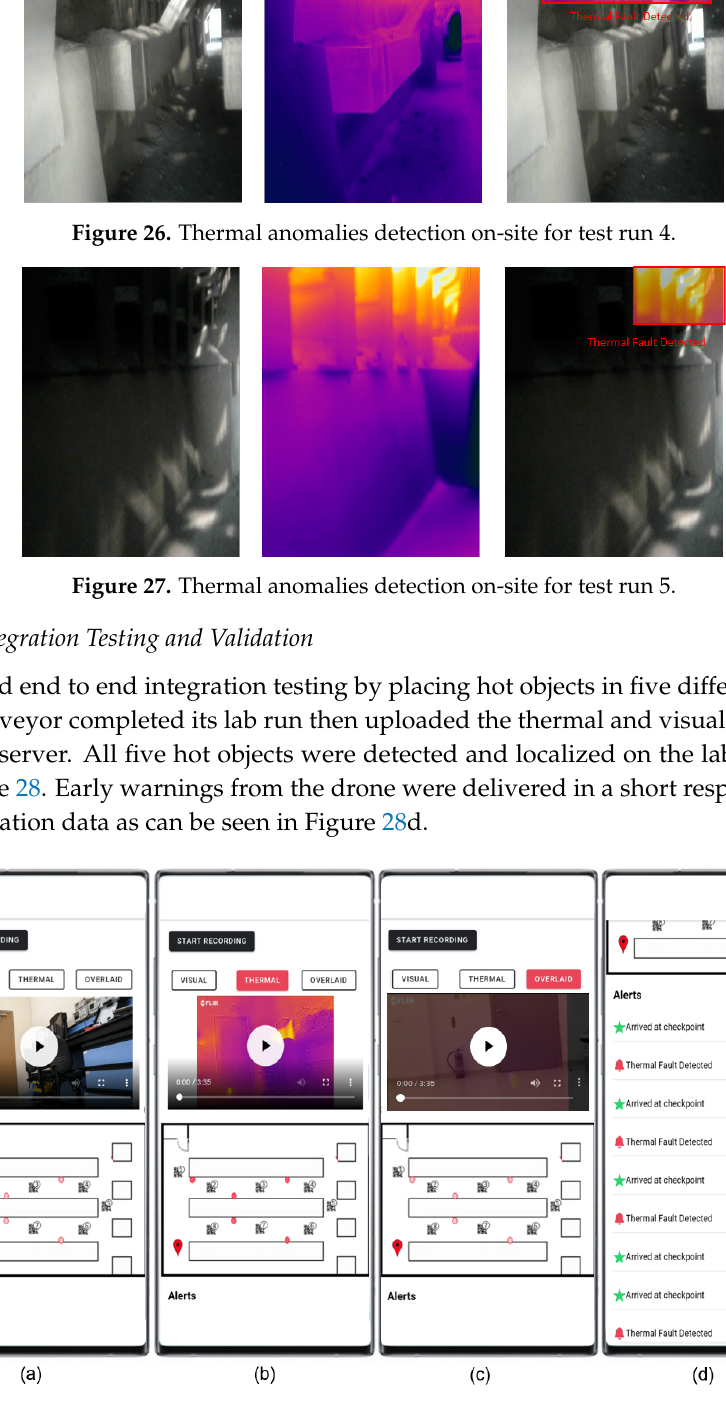
Figure 28. Mobile app displaying alerts and showing the localization and the ability to switch between the different views to be able to analyze thermal anomalies: ( a ) shows the visual view, ( b ) shows the thermal view while ( c ) shows the registered view. ( d ) shows the alerts